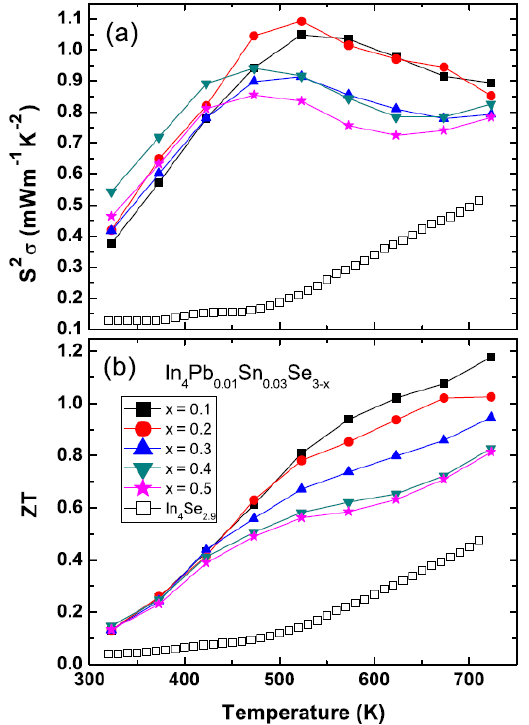
Figure 21. Temperature-dependent power factor S 2 σ ( a ), and dimensionless figure-of-merit ZT ( b ) of In 4 Pb 0.01 Sn 0.03 Se 3 − x ( x = 0.1, 0.2, 0.3, 0.4, and 0.5) polycrystalline